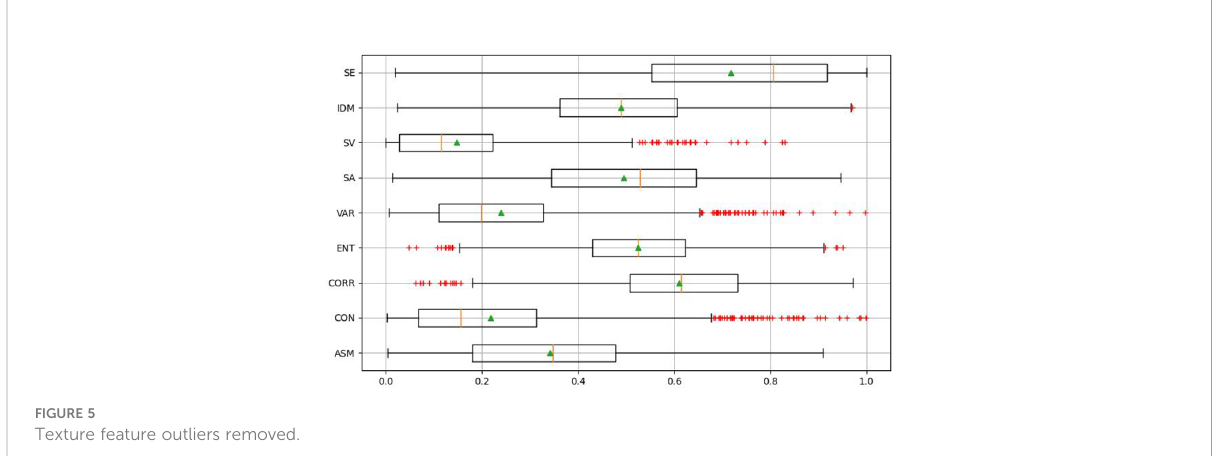
FIGURE 5 Texture feature outliers